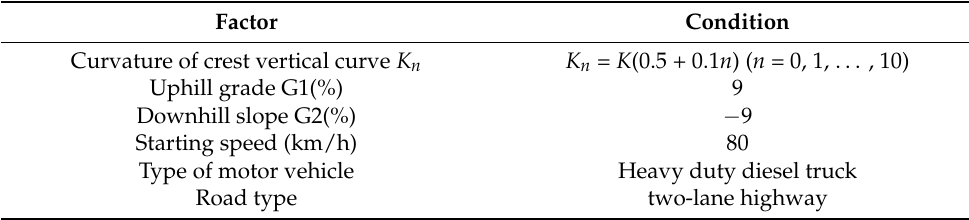
Table 1. Simulation scheme of the grade change point section. Factor Condition Curvature of crest vertical curve K